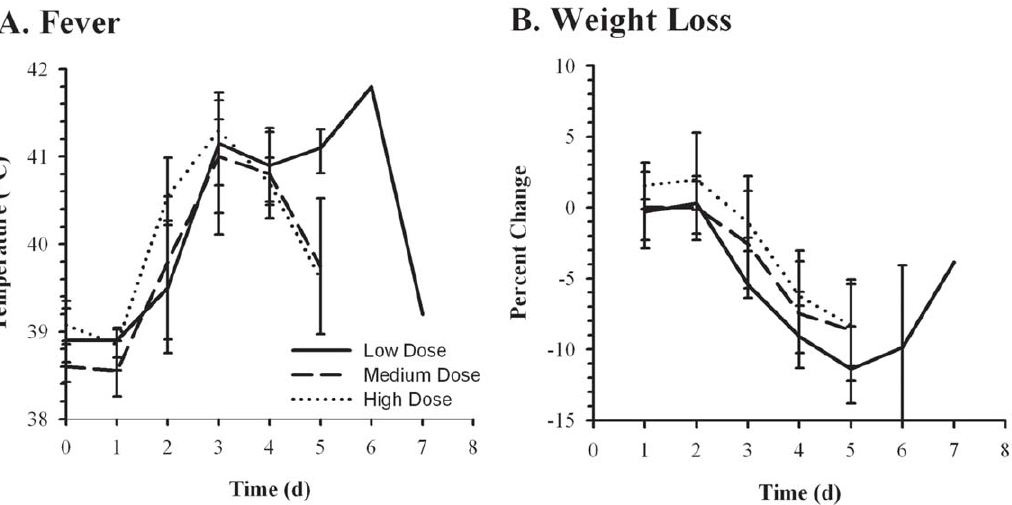
Figure 1. Fever and weight loss after inhalation of F. tularensis. NZW rabbits were exposed to low ( , 3000 cfu, solid lines), medium (3000– 9000 cfu, dashed lines), or high ( . 9000 cfu, dotted lines) presented doses of F. tularensis SCHU S4 and monitored for changes in body temperature ( A ) and weight ( B ). Graphs show averaged values for each timepoint postexposure with error bars representing the standard deviation. doi:10.1371/journal.pone.0024654.g001 PLoS ONE |